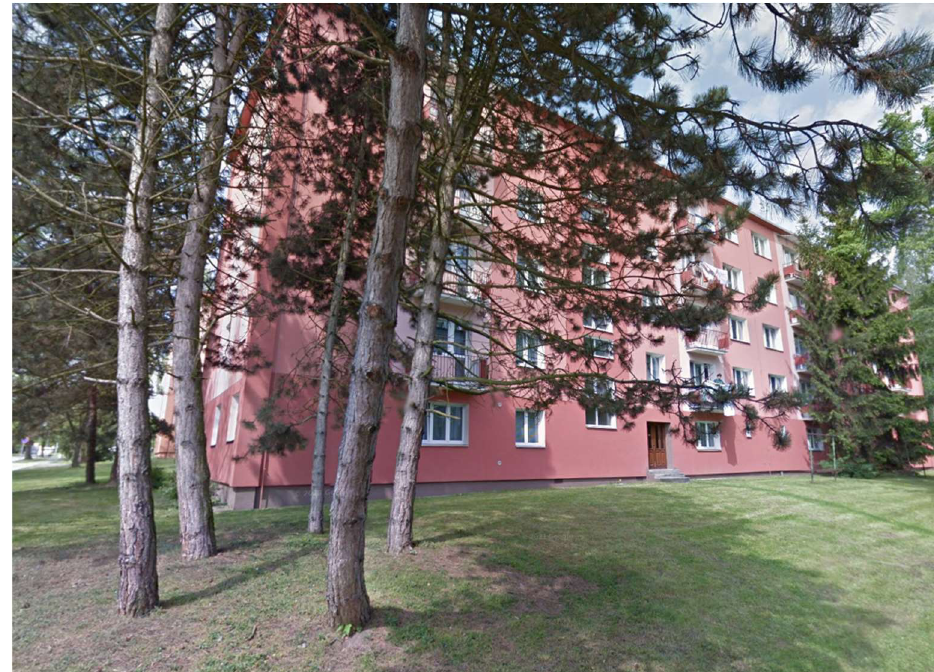
Figure 6. The housing estate environment.